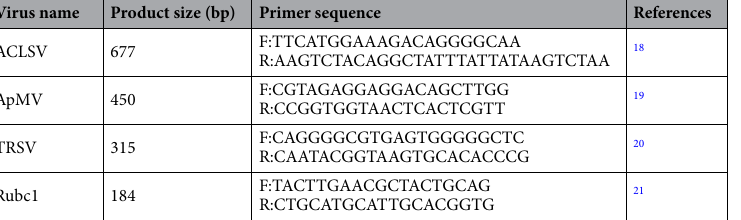
Table 2. The sequence of primer pairs used to amplify a specific sequence in cDNA of each examined virus. Primers to amplify part of a Rubisco subunit cDNA used as